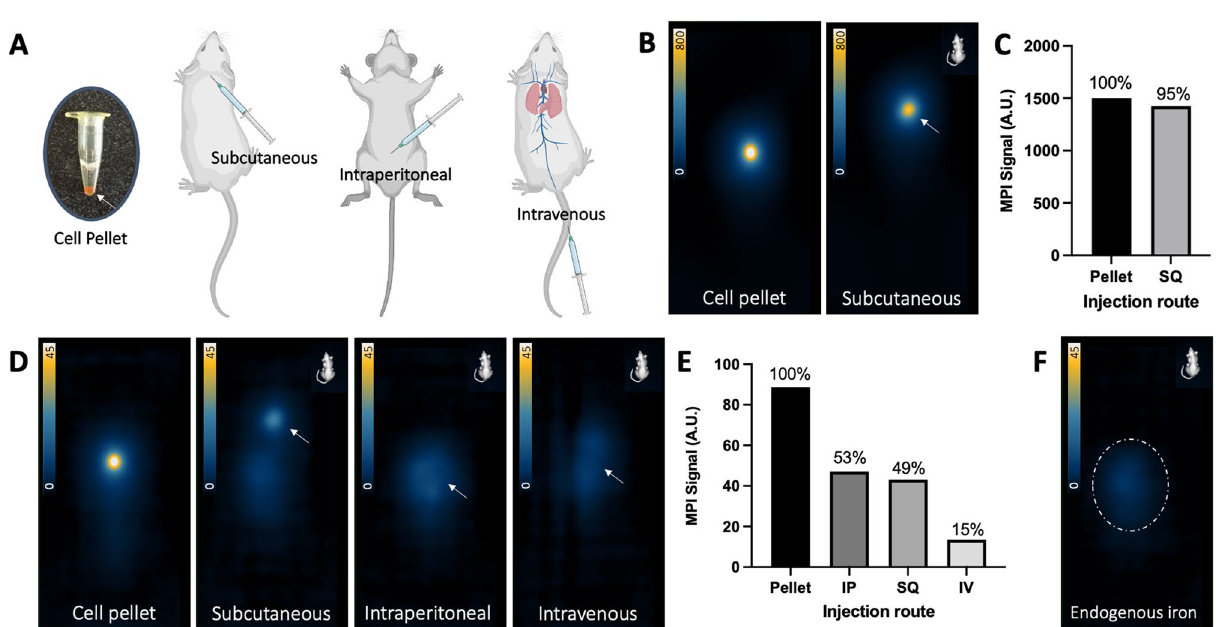
Figure 6. ( A ) Cartoon showing subcutaneous (SQ), intraperitoneal (IP), and intravenous (IV) injection in mice. ( B ) Comparison of MPI signal from 2D scans of 2 × 10 6 ferucarbotran-labeled MSC in a cell pellet to subcutaneous injection. ( C ) Measured MPI signal from 2 × 10 6 MSC was similar in vivo and ex vivo. ( D ) Detection in 2D of 1 × 10 5 ferucarbotran-labeled MSC as a cell pellet and after subcutaneous, intraperitoneal, and intravenous injection. ( E ) Measured MPI signal from 1 × 10 5 cells is reduced in vivo compared to signal in the pellet. ( F ) Some background MPI signal exists owing to iron in mouse digestion. This signal was minimized with 12-h fasting and accounted for by subtracting pre-injection signal from post-injection signal for each